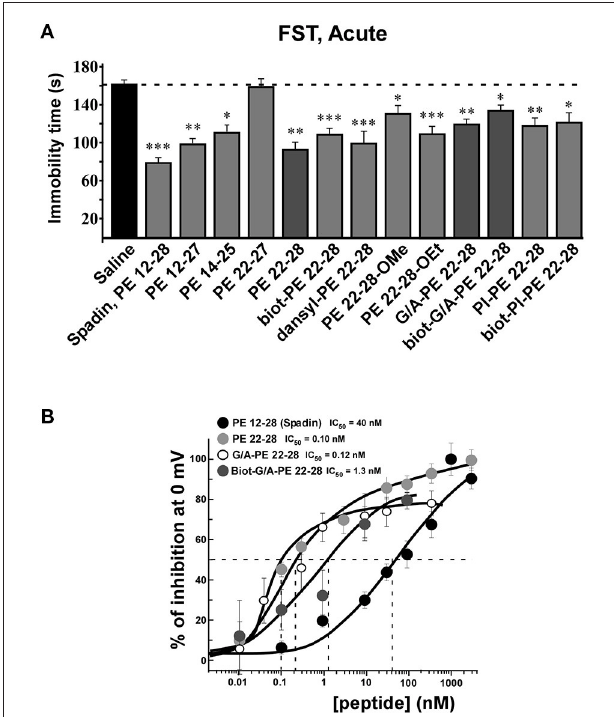
FIGURE 3 | FST and dose-response curves of TREK-1 current inhibition by spadin-analogs. (A) Peptides able to inhibit TREK-1 channel activity were tested in the FST. Immobility times were measured 30 min after ip injection and compared with the immobility time obtained with saline injected mice. Spadin was injected at 100 µ g/kg and spadin-analogs were injected at 3.2–4.0 µ g/kg. * p < 0.05, ** p < 0.01, *** p < 0.001. (B) Dose-response curves of TREK-1 current inhibition at 0 mV obtained with spadin-analogs compared with spadin. IC 50 were 0.1, 0.12, 1.2, and 40.0 nM for PE 22-28, G/A-PE 22-28, biotinylated-G/A-PE 22-28 and spadin,